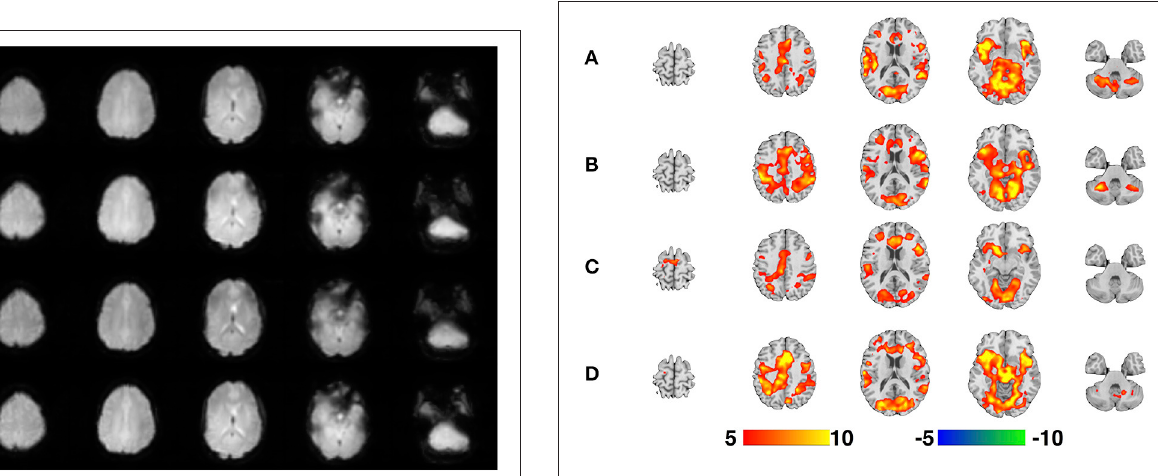
FIGURE 2 | Realigned images for each EPI sequence for one participant. (A) SHORT, TR = 700 ms; (B) AVG2, TR effective = 1400 ms; (C) AVG4, TR effective = 2800 ms; (D) REF, TR = 1440 ms. Slices were created using Mango (http://ric.uthscsa.edu/mango/; Jack L. Lancaster and Michael